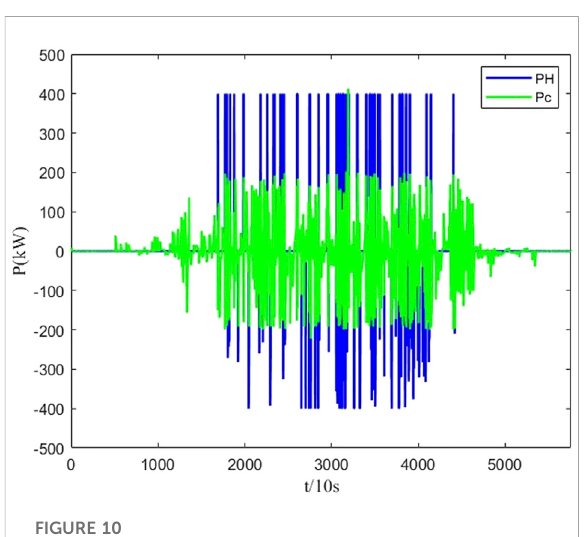
FIGURE 10 Simulation results of charge and discharge